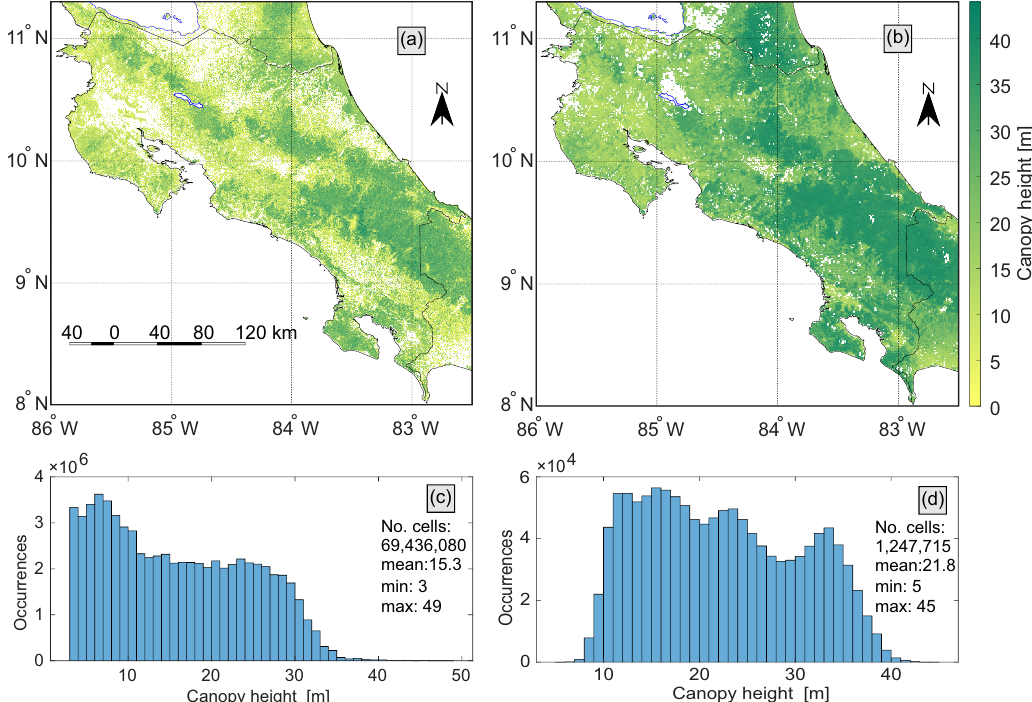
Figure 4. Canopy height models: ( a ) 25 m mesh size Global Forest Canopy Height 2019 (GFCH2019) model. ( b ) 1km mesh size Forest Canopy Height Map (FCHM). Both models are plotted with the same colour bar limits. ( c ) Histogram of GFCH2019 for the area of study. ( d ) Histogram of the FCHM for the area of